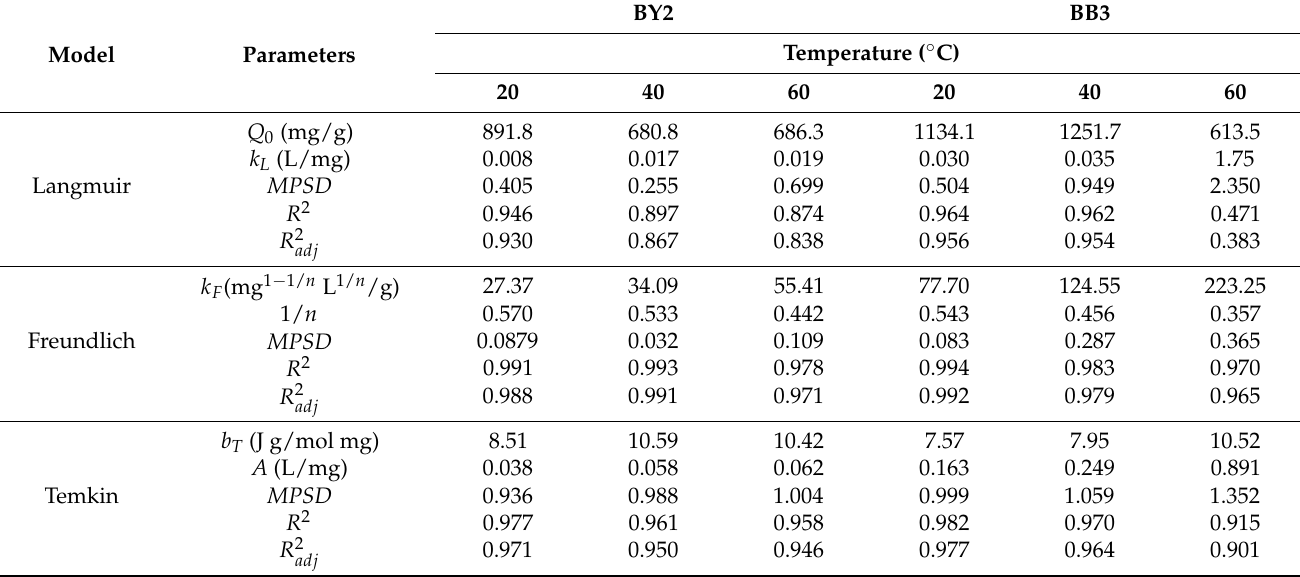
Table 3. Parameters of the Freundlich, Langmuir, and Temkin isotherm models calculated for the adsorption systems at 20–60 ◦ C using non-linear regression.